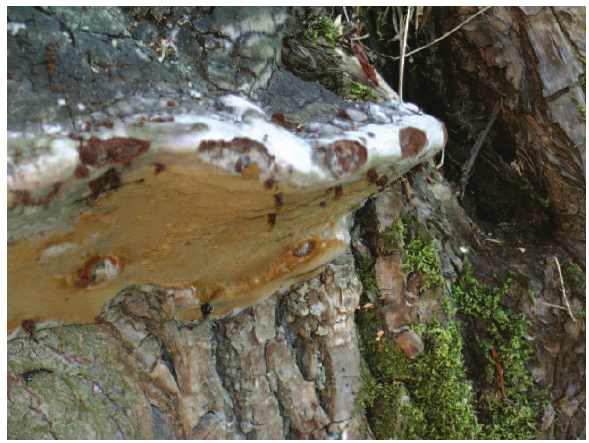
Fig. 3. Carpophore of the false esca fungus,